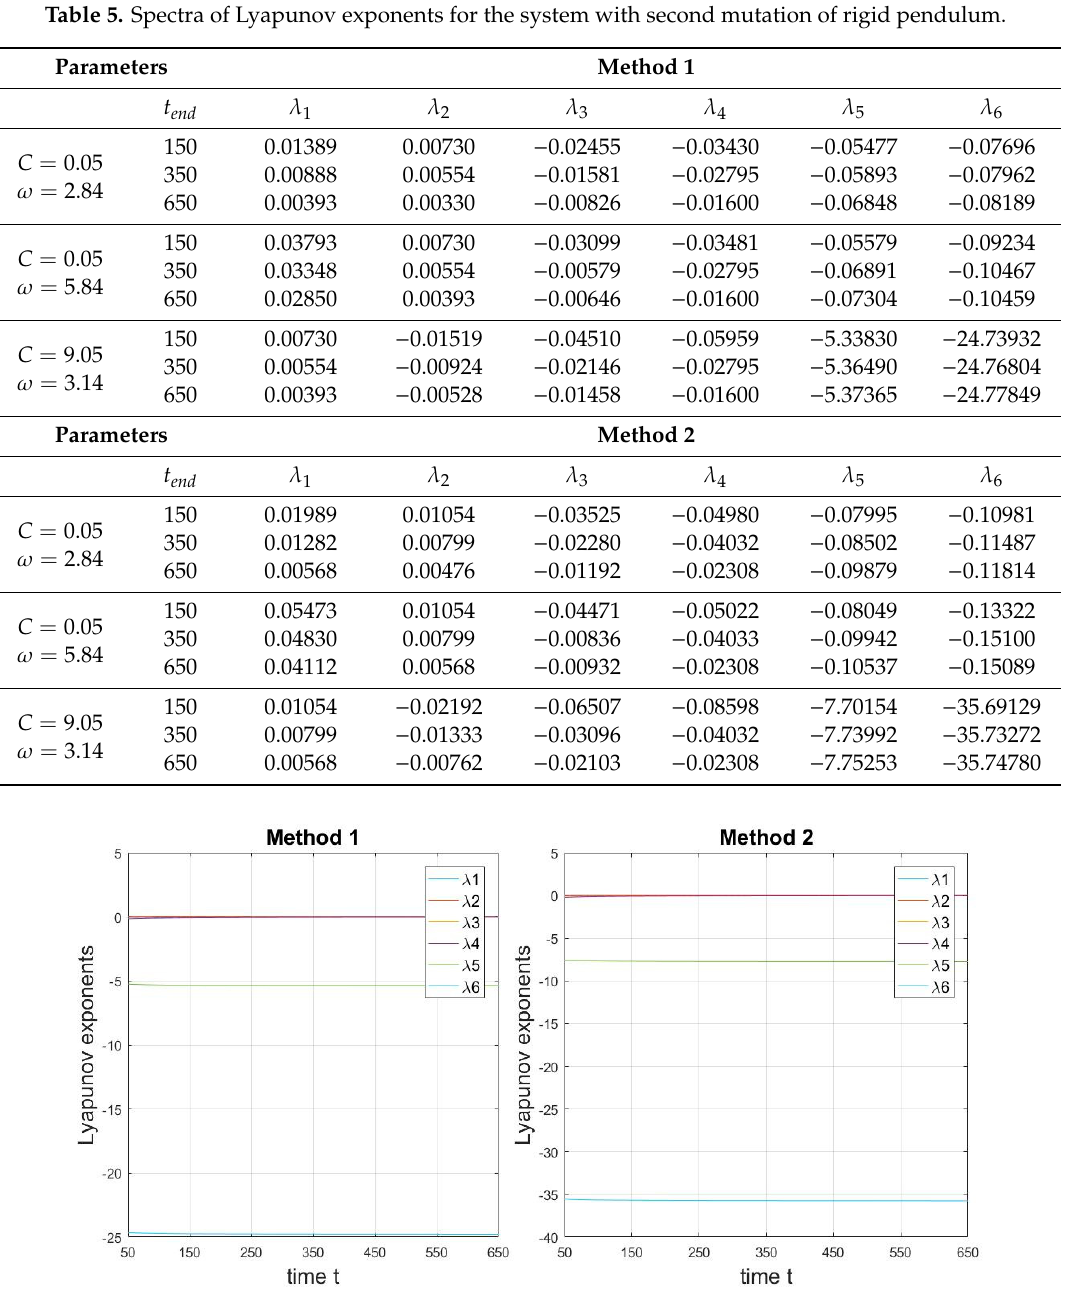
Figure 14. Time history of Lyapunov exponents starting at t = 50 for C = 9.05, k = 40 and ω = 3.14 .